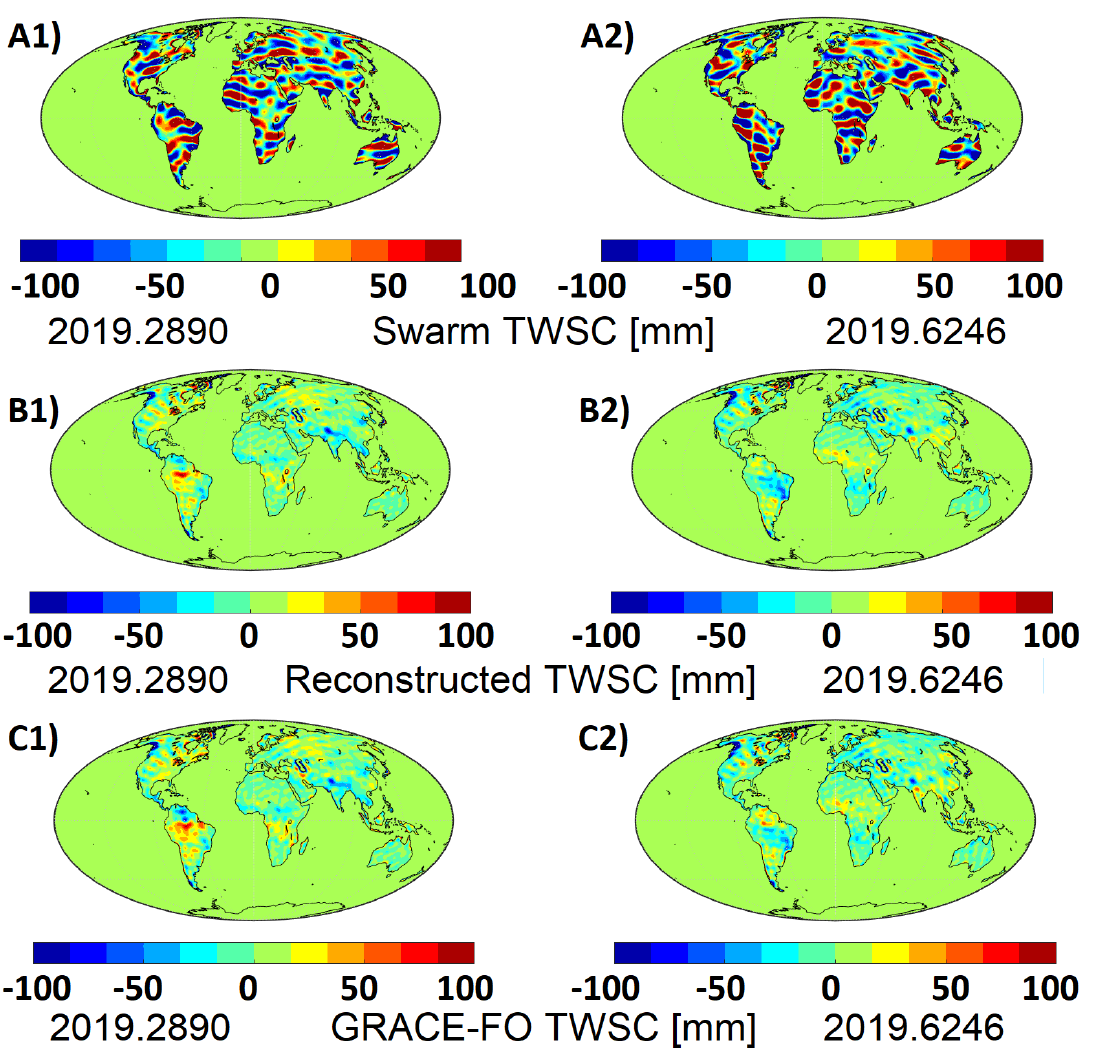
Figure 4. The reconstruction results of Approach 2 and their comparisons with Swarm and GRACE-FO data; ( A1 , A2 ) show the original Swarm fields in 2019.2890 (March 2019) and 2019.6246 (July 2019), respectively; ( B1 , B2 ) indicate the reconstruction results of Approach 2; ( C1 , C2 ) represent those of GRACE-FO that were not used during the reconstruction. A mask was used to retain the signal over the